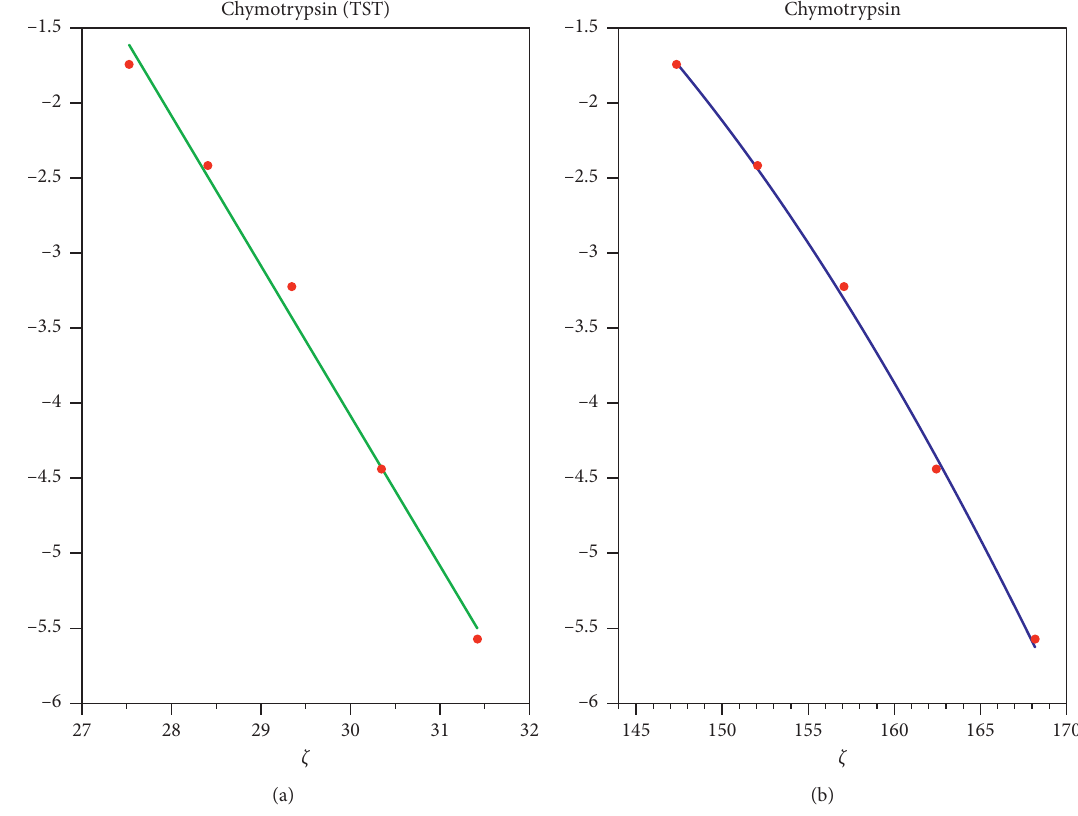
Figure 4: Eyring plots [3] according to TST (green) of rate coefficients for the hydrolysis of Suc-Ala-PhepNA catalyzed by α -chymotrypsin. The corresponding curve from equation (8), with a � 133 , ] ( z experimental data in